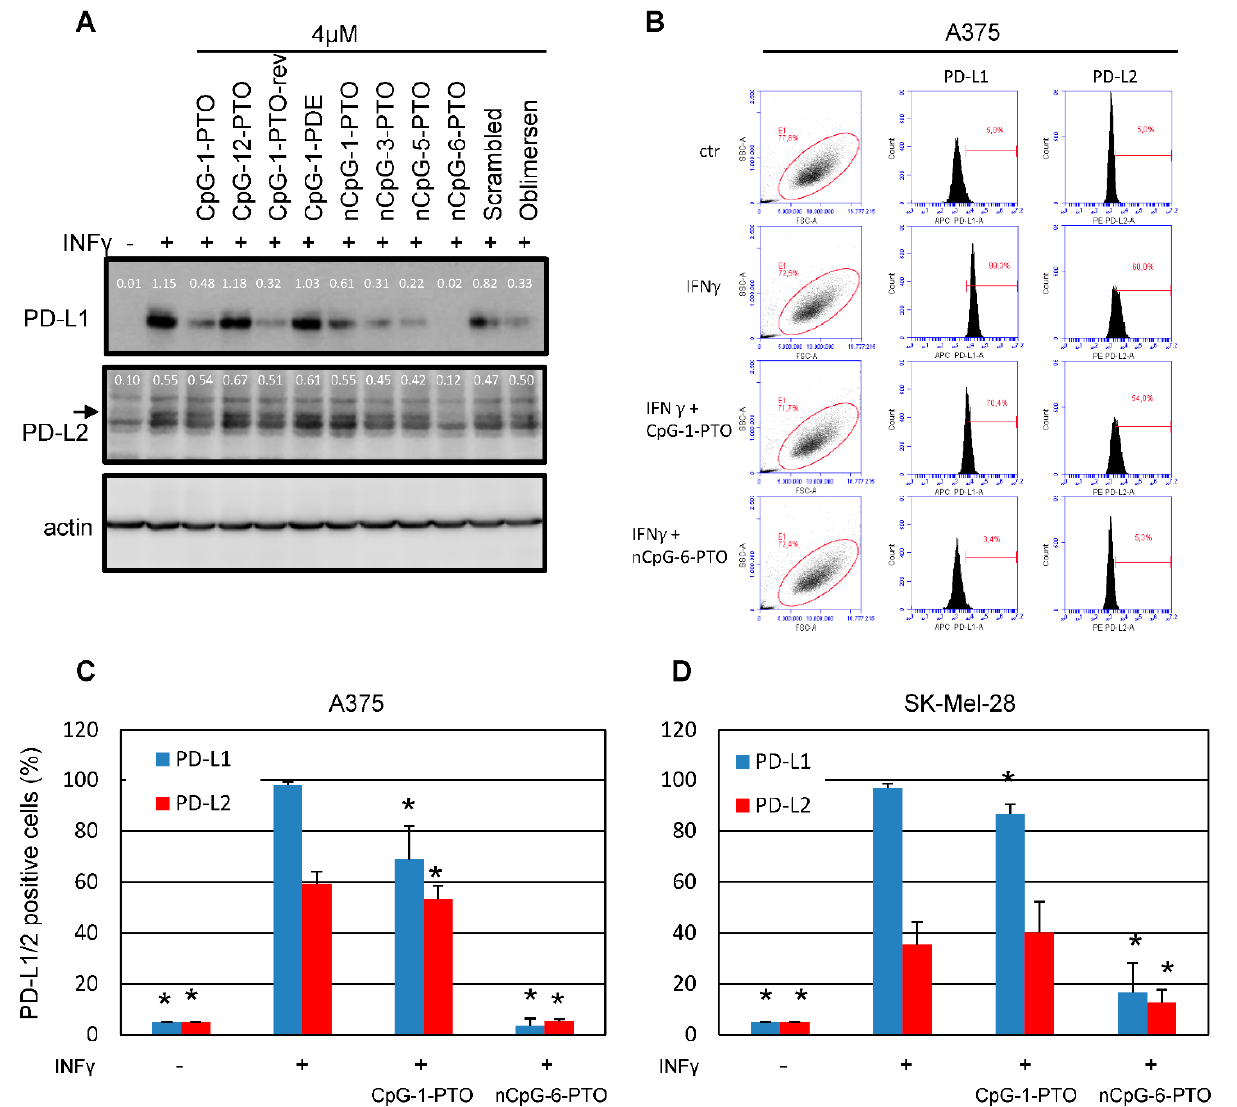
Figure 1. Oligonucleotides suppress the protein expression of PD-L1 and PD-L2. ( A ) A375 melanoma cells prestimulated for 1 h with IFN γ (20 ng/mL) were exposed to different oligonucleotides (4 µ M). Oligo characteristics in regard to backbone and sequence are given in Table 1. After 24 h, total protein was extracted and separated by SDS-PAGE. The blotted proteins were probed with anti-PD-L1 and anti-PD-L2. Probing with anti-beta actin served as loading control. The images show representative results. ( B ) Exemplary result of a FACS scan against PD-L1 and PD-L2 after treatment with 4 µ M CpG-1-PTO and 4 µ M nCpG-6-PTO in A375 cells. Summary of 9 independent FACS experiments using ( C ) A375 and ( D ) SK-Mel-28 cells treated with 4 µ M CpG-1-PTO or nCpG-6-PTO. The standard deviations are indicated. Data were related to the referring positive control (IFN γ ). * p <